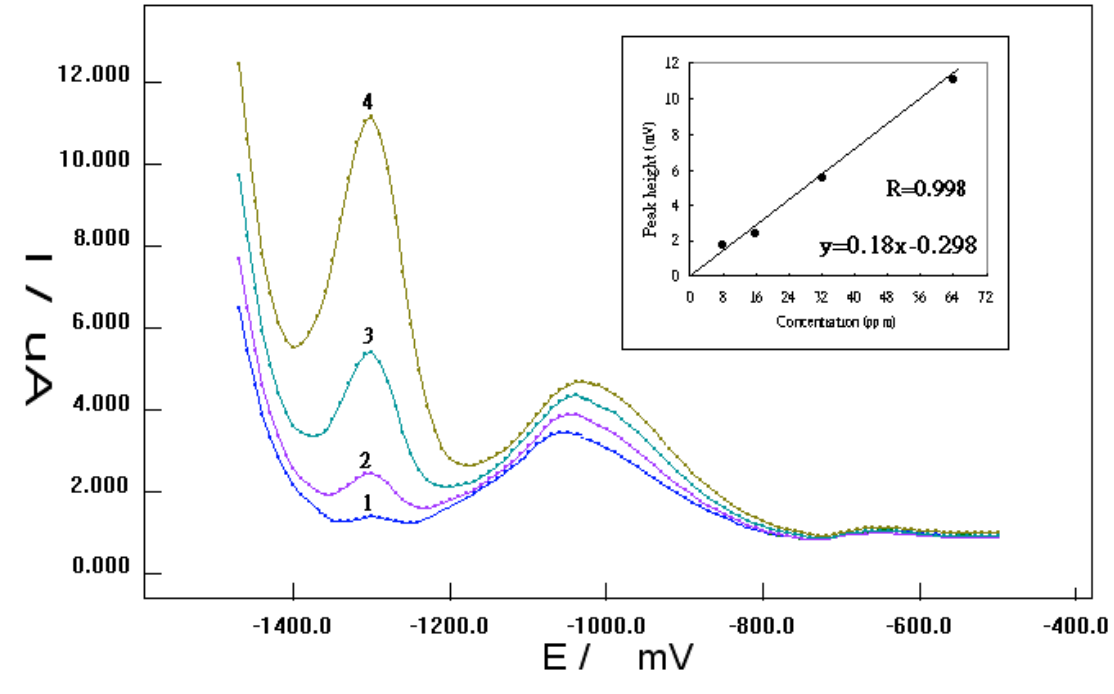
Figure 6. (a) Magnitude of the peak current, i rate for NDELA reduction, and (b) peak potentials as a function of the logarithm of the scan rates for NDELA reduction.